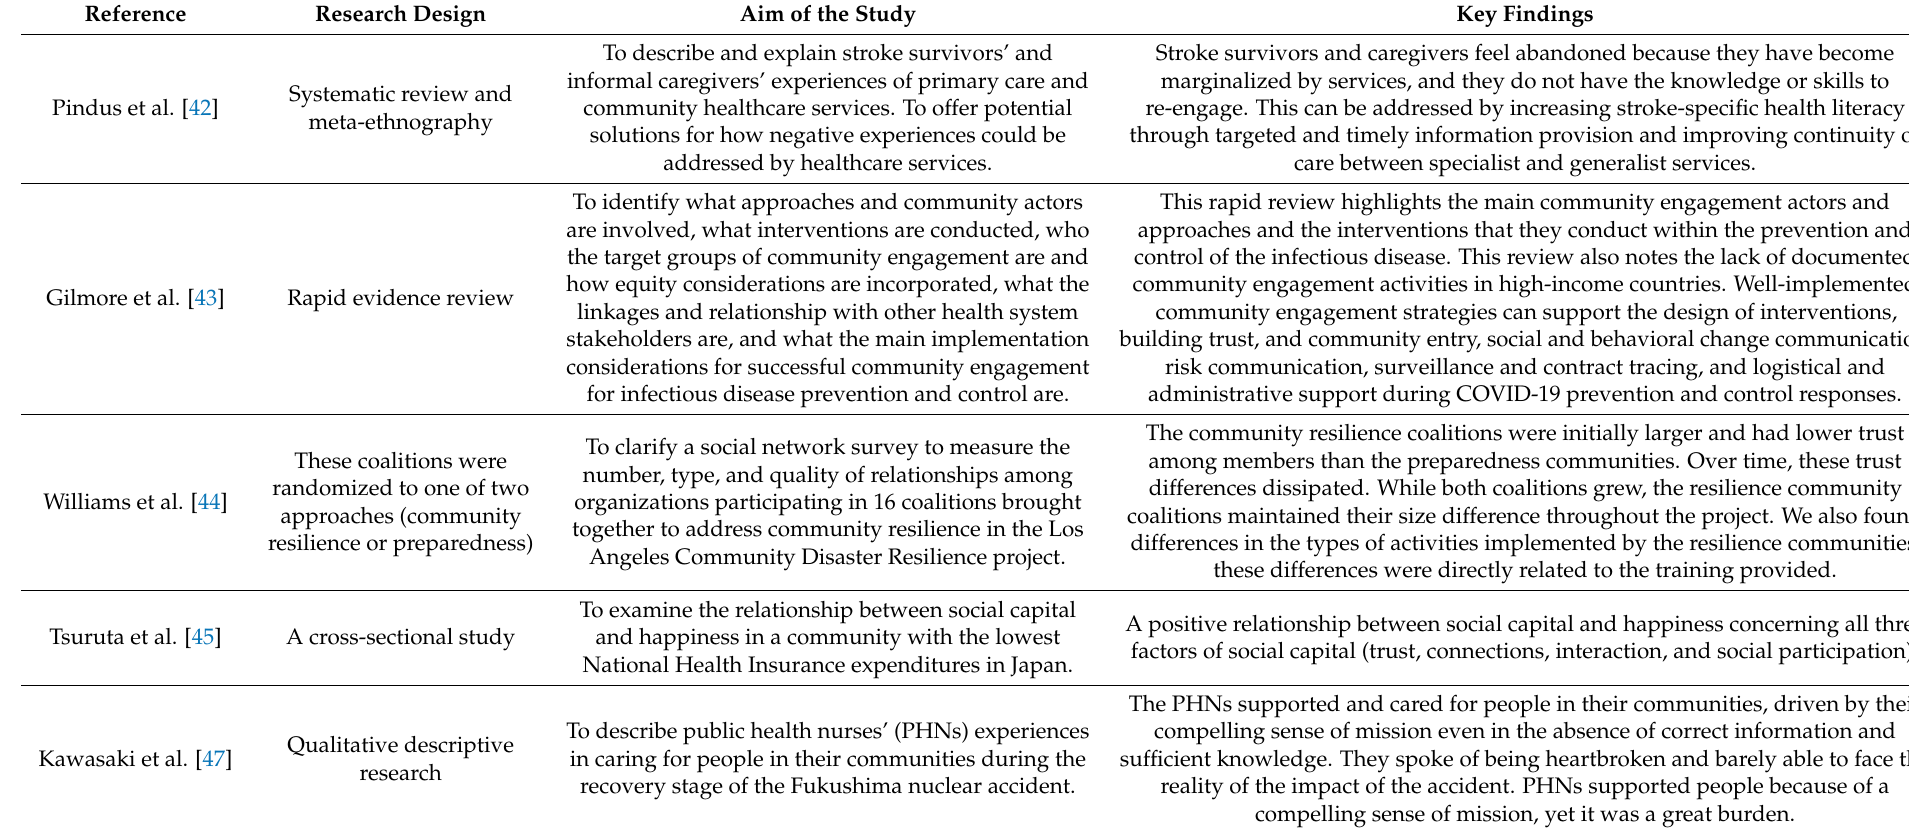
Table 1. Summary of studies